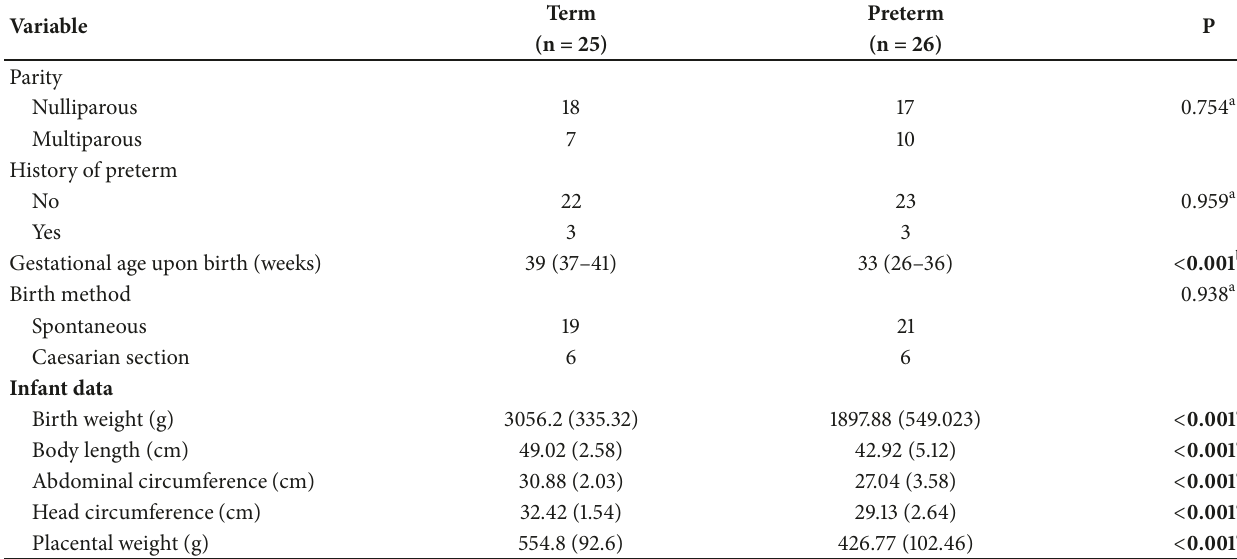
Table 2: Maternal obstetric status and pregnancy outcome. Apart from the apparent characteristic of preterm birth, no significant difference was found between